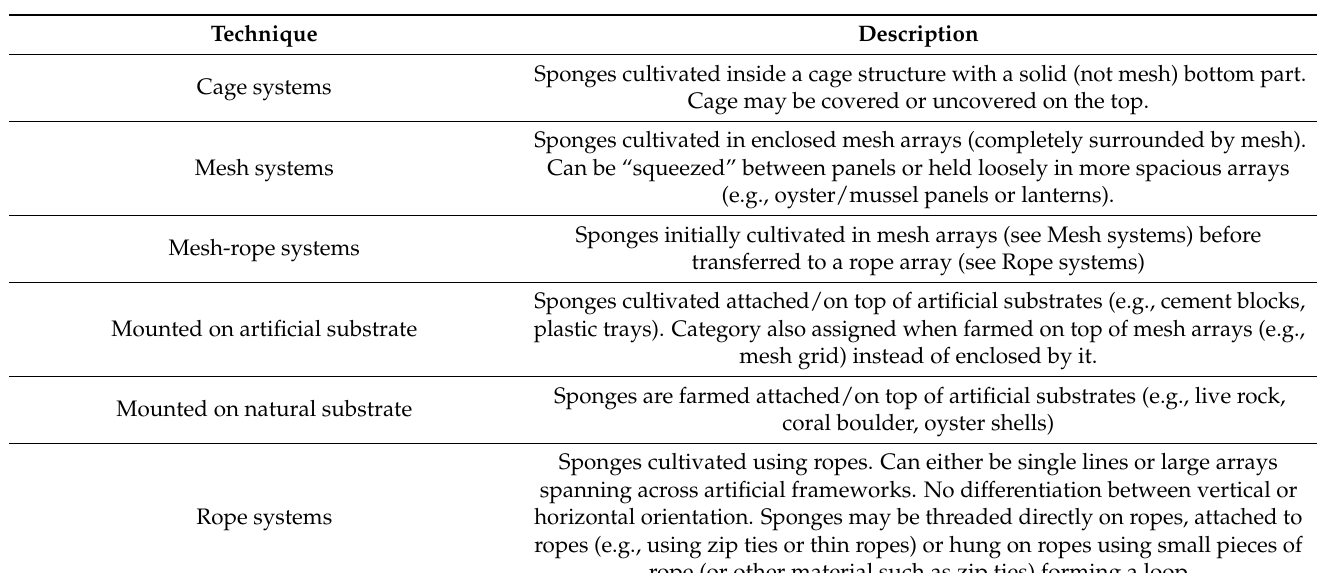
Table 2. Description of categorized transplantation techniques.